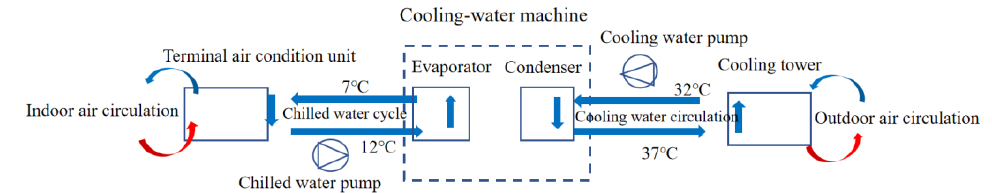
Figure 1. A schematic diagram of the working principle of a central air conditioning system. The central air conditioning refrigeration system can be divided into two main cate- gories. One is the direct refrigeration system, and the other is the indirect refrigeration system. The direct refrigeration system has only one circuit, named the refrigerant circuit, while the indirect refrigeration system contains at least two circuits, named the refrigerant and the refrigerant carrier. In a direct refrigeration system, the evaporator is used directly for cooling the ambient air, while in the indirect refrigeration system, the refrigerant first cools the carrier refrigerant, and then travels through the carrier refrigerant to cool the air. Normally, the refrigerant carrier is the chilled water. The coolant is the cooling water. Large central air conditioning systems are indirect refrigeration systems. For the conven- ience of the narrative, chilled water is used instead of refrigerant carrier, and cooling water instead of coolant, in the latter. The central air conditioning system includes the air system, the water system, and the heat and cold source system, of which the water system is the main energy consump- tion system, consuming more than half of the total energy consumption. Therefore, this study focuses on the water system in central air conditioning systems. 2.2. The Water System The water system is composed of two parts. One is the chilled water system and the other is the cooling water system. Research on chilled water system energy saving strate- gies is now relatively mature. By changing the flow rate of the chilled water system and controlling each piece of equipment to operate at the lowest power while meeting the load demand, a reduction in the system ’s energy consumption is achieved. Currently, central air conditioning systems are designed for ideal full load operation. However, in actual operation, if various internal and external factors are taken into account, the chances that the actual operating conditions will match the design operating conditions are extremely low. We deduce from this that a large number of devices are not operating at full load most of the time. This therefore results in a waste of power. When it comes to the water system, only 20 – 30% of central air conditioning water systems operate at full load, while partial load operation accounts for about 70 – 80% of cases. Therefore, it is very important to realize how to effectively reduce energy consumption and optimize energy saving con- trol under partial load in water systems. The cooling water system, as an important part of the central air conditioning system, is controlled in a way that has a significant impact on the total energy consumption of the central air conditioning system. Therefore, a reasonable cooling water system control method is important for the energy saving operation of central air conditioning systems. The control schemes for water systems can be divided into two types: constant flow con- trol and variable flow control. When the water system operates at a fixed flow rate, all equipment operates at the conditions set at the beginning, without any optimization con- trol equipment. In practice, the three-way valve is often used to change the amount of water passing through the metered cooler. This method is simple to operate and stable in operation. However, it also has obvious disadvantages. The system water volume is de- termined based on the maximum load. During the vast majority of the time, the water supply is greater than the required amount of water. Therefore, the pump energy loss is still relatively high. Energy saving optimization of variable flow systems is more in line with the current trend. When a central air conditioning water system transfers heat,